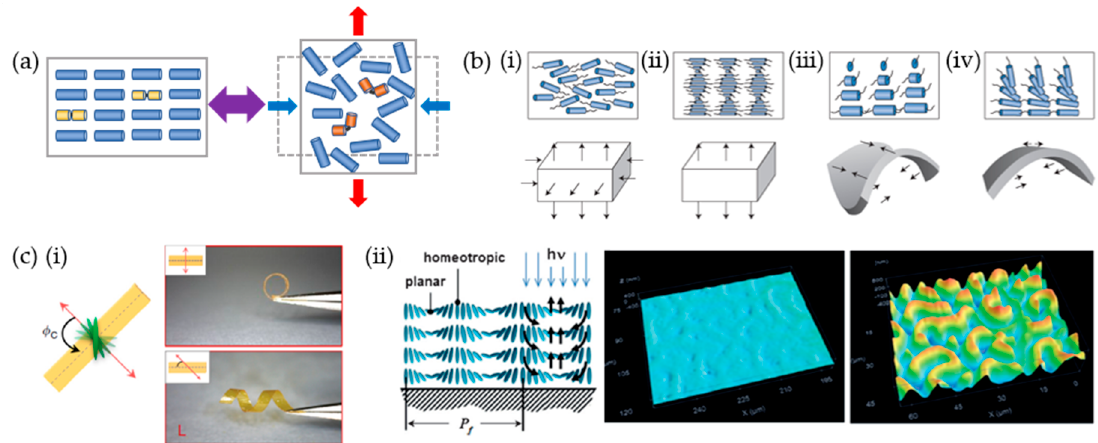
Figure 6. Principles of shape morphing for liquid crystalline polymers. ( a ) Schematic of the light-induced shape change of a liquid crystalline polymer resulting from the order–disorder transition. ( b ) Representation of the dimension changes in liquid crystalline polymers through order–disorder transition upon exposure to external stimuli: ( i ) uniaxial, ( ii ) cholesteric, ( iii ) twisted nematic, and ( iv ) hybrid geometry for liquid crystal polymers. ( c ) Molecular alignment-dependent actuations: ( i ) Bending and twisting depends on offsetting ( Φ c ) the nematic director of the molecule at midplane (red arrow) and the cutting direction (dotted line), ( ii ) 3D image of a dynamic fingerprint under UV exposure with a homeotropic to planar alignment. ( b ) Reproduced with permission [54]. Copyright 2015, Nature Publishing Group. ( c ) ( i ) Reproduced with permission [70]. Copyright 2014, Nature Publishing Group. ( ii ) Reproduced with permission [71]. Copyright 2014, Nature Publishing Group.